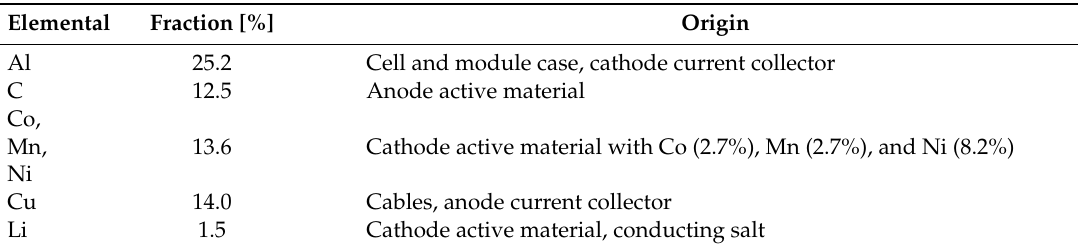
Table 2. Fraction of specific metals and graphite in a generic battery module with an